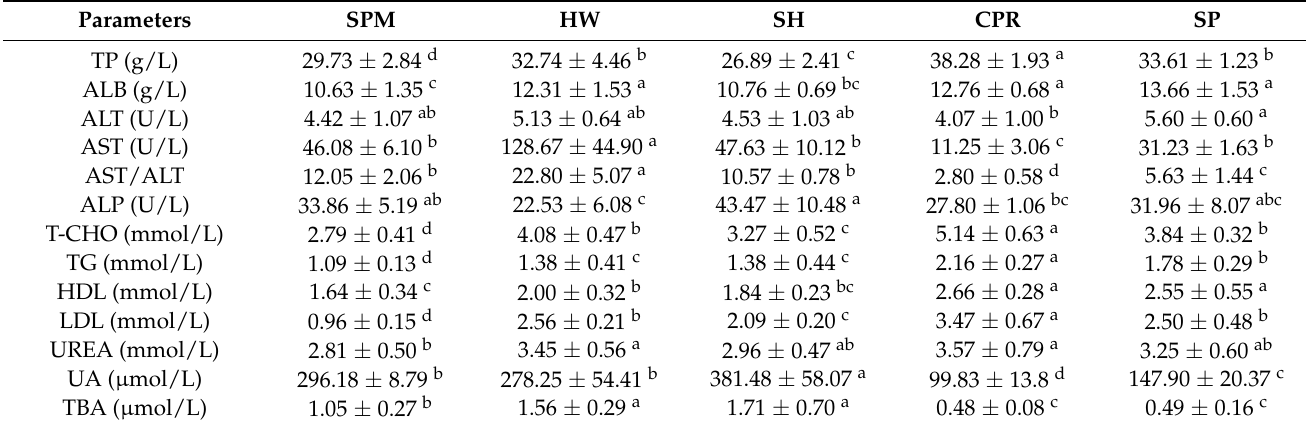
Table 9. Serum biochemical parameters in five species of common